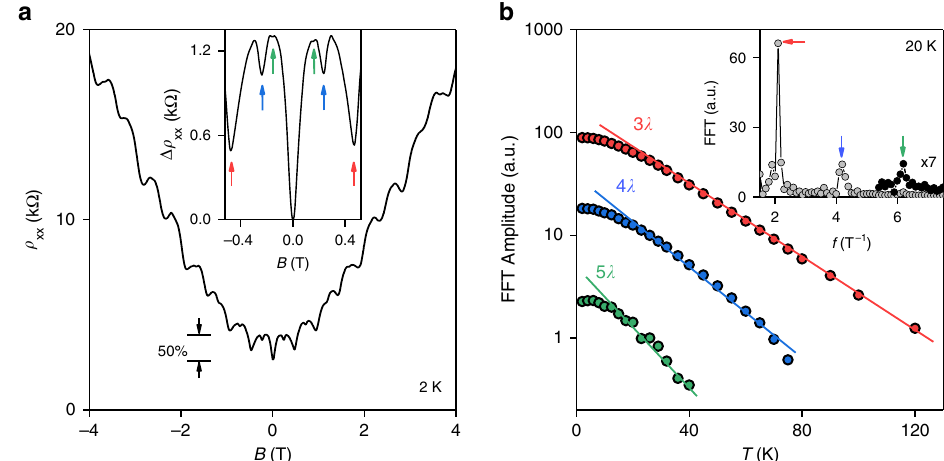
Fig. 2 High-order harmonics in the Aharonov – Bohm oscillations. a Typical magnetoresistance curves near the main NP ( T = 2 K, D = 0.5 V nm − 1 ). Insert: Zoom-in close to zero B . The arrows mark the minima that correspond to ϕ piercing one (red), two (blue) and three (green) triangular domains shown 0 in Fig. 1a. b Temperature dependence for the three oscillation frequencies (symbols). Solid lines: Guides to the eye indicate that the slopes for the 2nd and 3rd harmonics are, respectively, ∼ 4/3 and 5/3 times steeper than for the main frequency. Insert: Example of our fast-Fourier-transform (FFT) analysis (gray circles). The peaks are marked using the same color coding as in a . The third-harmonic peak is magni fi ed for clarity (black